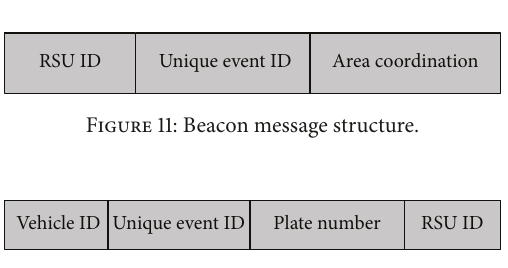
Figure 12: Advisory speed limit requests message structure.